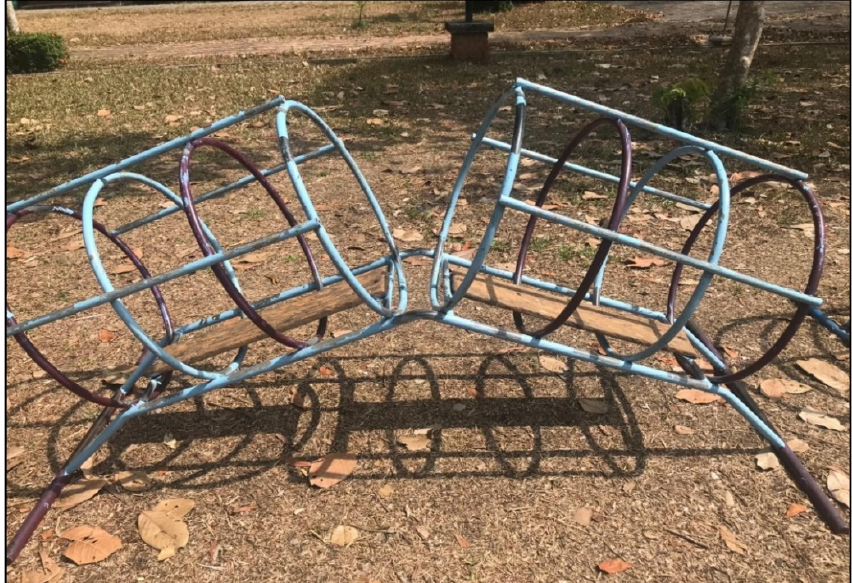
Figure 4. Tube slide: The diameter of the tube slide was less than 75 cm. Color paint had peeled off of the playground equipment.